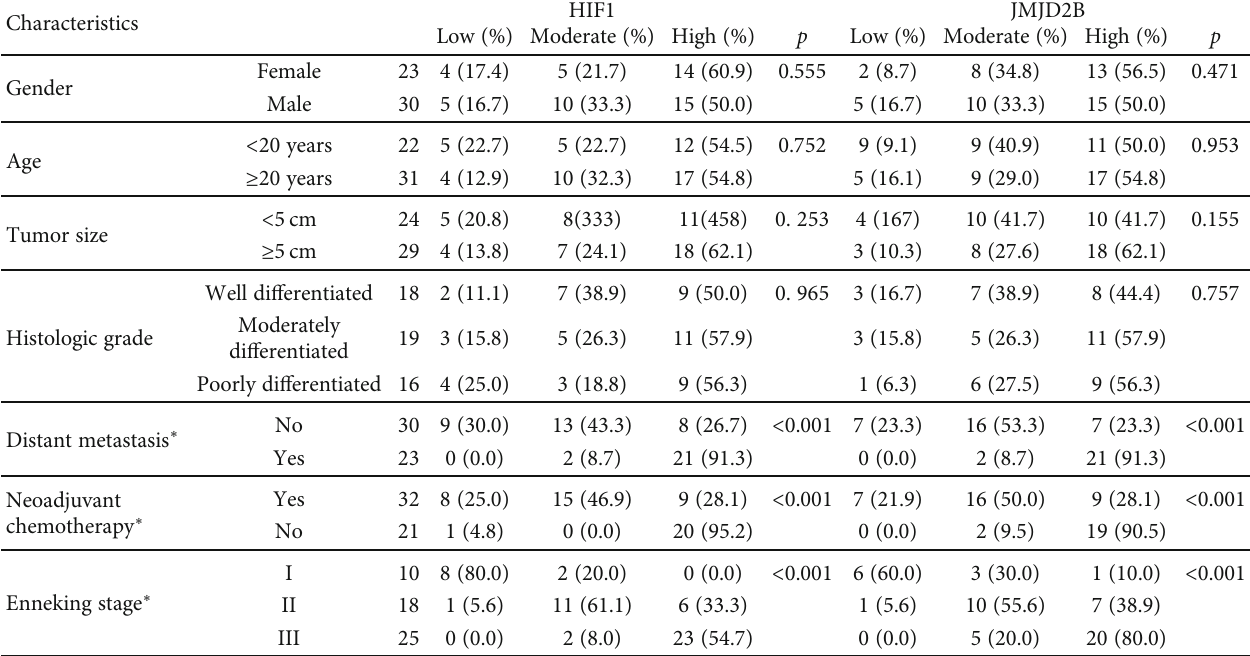
Table 1: Clinicopathological variables and HIF1 and JMJD2B expressions in OS patients.